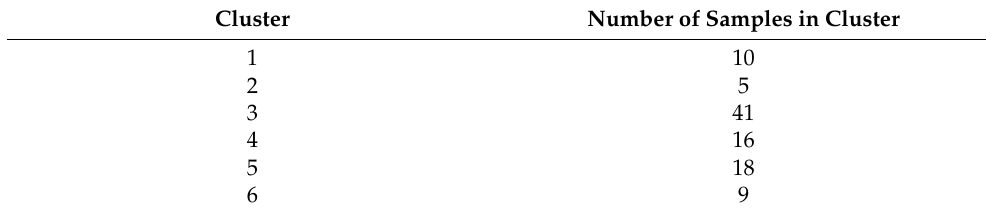
Table 5. The number of samples in each cluster.